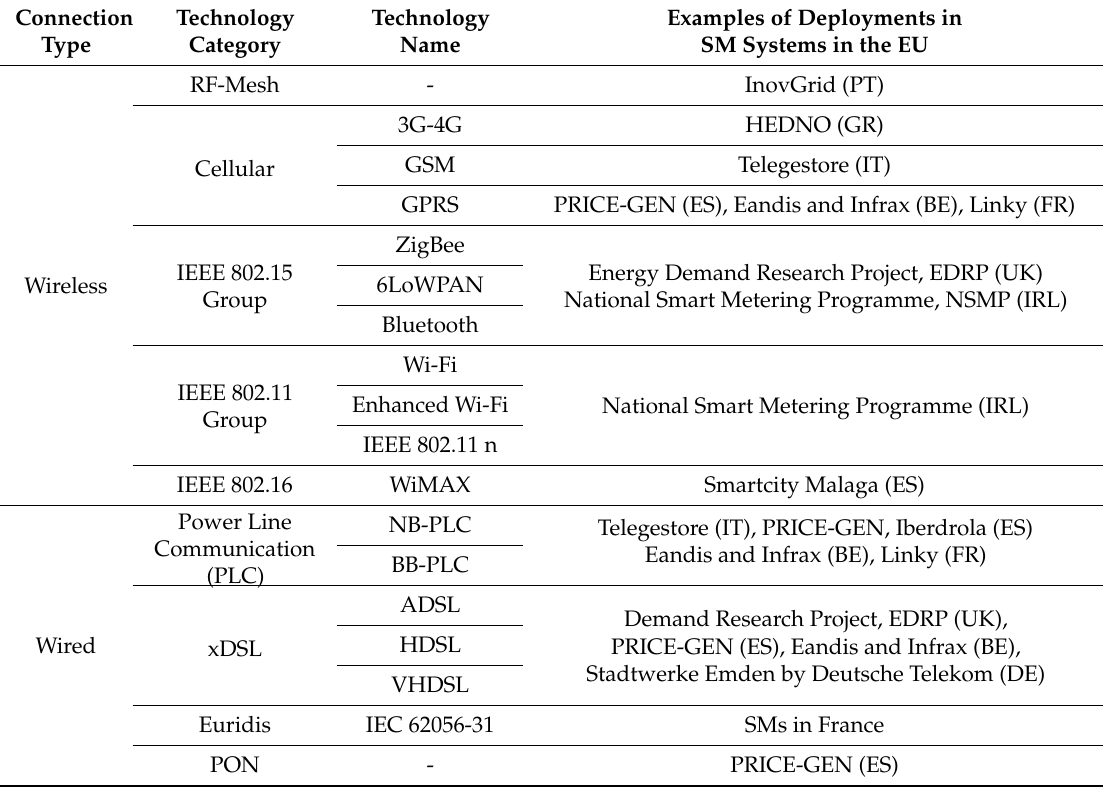
Figure 1. Electricity smart meter roll-out rates in EU MSs and in Norway in 2017 (%). Reproduced with permission from the Agency for the Cooperation of Energy Regulators and the Council of European Energy Regulators, ACER and CEER, Annual Report on the Results of Monitoring the Internal Electricity and Natural Gas Markets in 2017. s.l.: ACER / CEER, 2018 Table 1. Communication technologies used in smart metering (SM) in the EU (Authors’ work based on